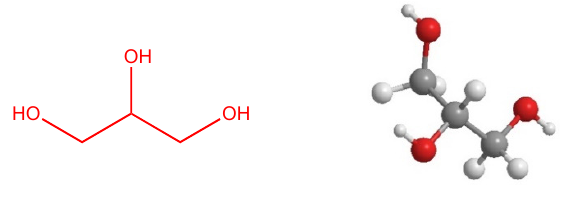
Figure 1. Glycerol (1,2,3-propanetriol) structure.